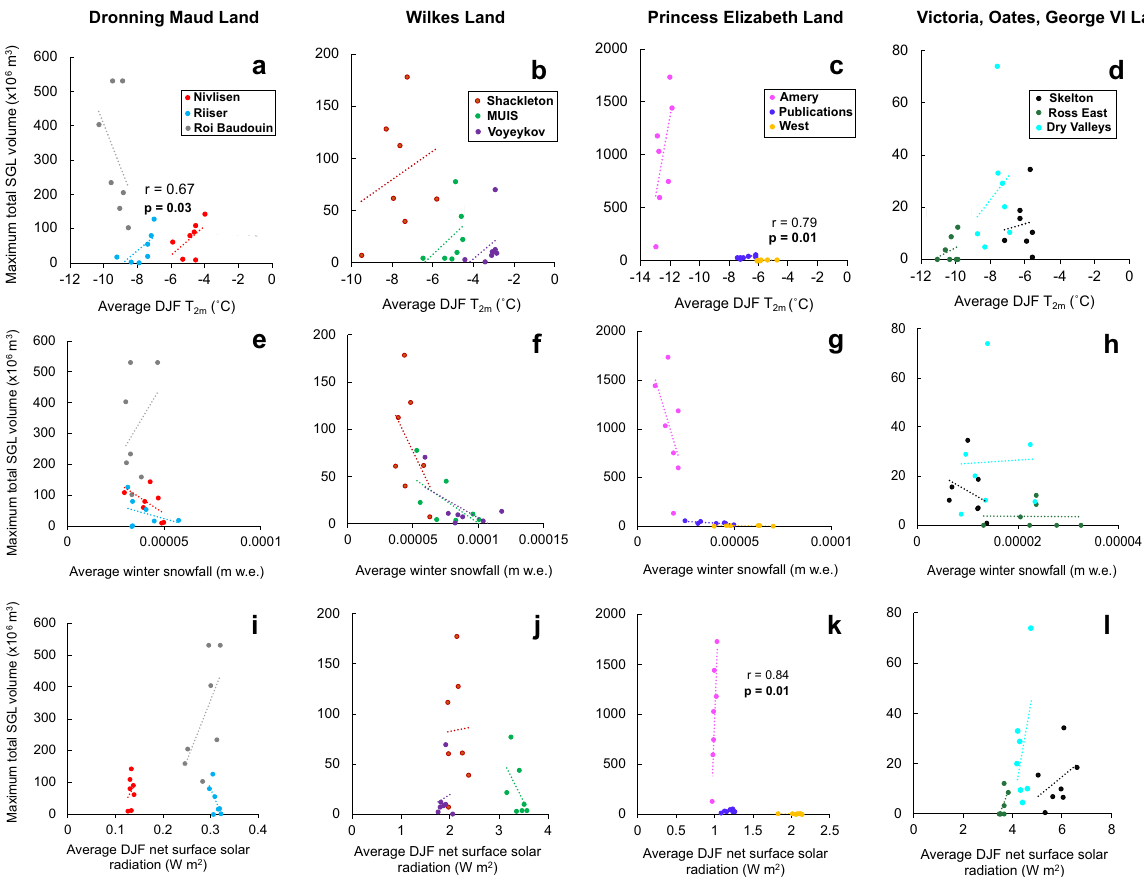
Fig. 5 Relationships between climatic variables and supraglacial lake volumes on the East Antarctic Ice Sheet. Scatter plots of mean December-January- February (DJF) 2-m temperature (T 2m ) ( a – d ) mean snowfall in the preceding winter (February to December) ( e – h ) and mean DJF net surface solar radiation (S rad ) ( i – l ) from ice shelf grounding zones simulated by ERA5 reanalysis (see Methods) and maximum total SGL volume grouped by major EAIS region. Individual ice shelves are represented by different colours (see Fig. 1 for locations). Signi fi cant relationships ( p < 0.05) in a linear regression are